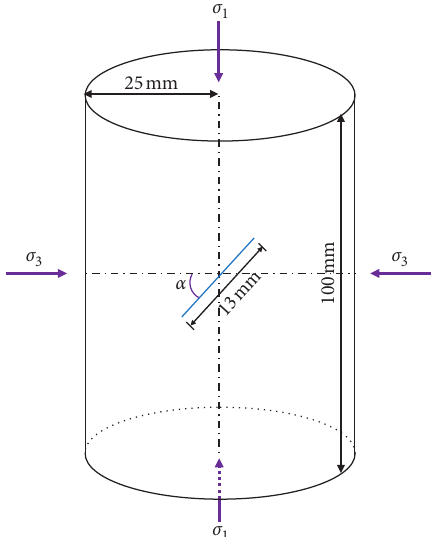
Figure 1: Triaxial compression test on a rock mass with a pre- existing fissure. σ and σ are the axial stress and confining 1 2 pressure, respectively. α denotes the inclination angle of the pre- existing fissure with reference to the horizontal